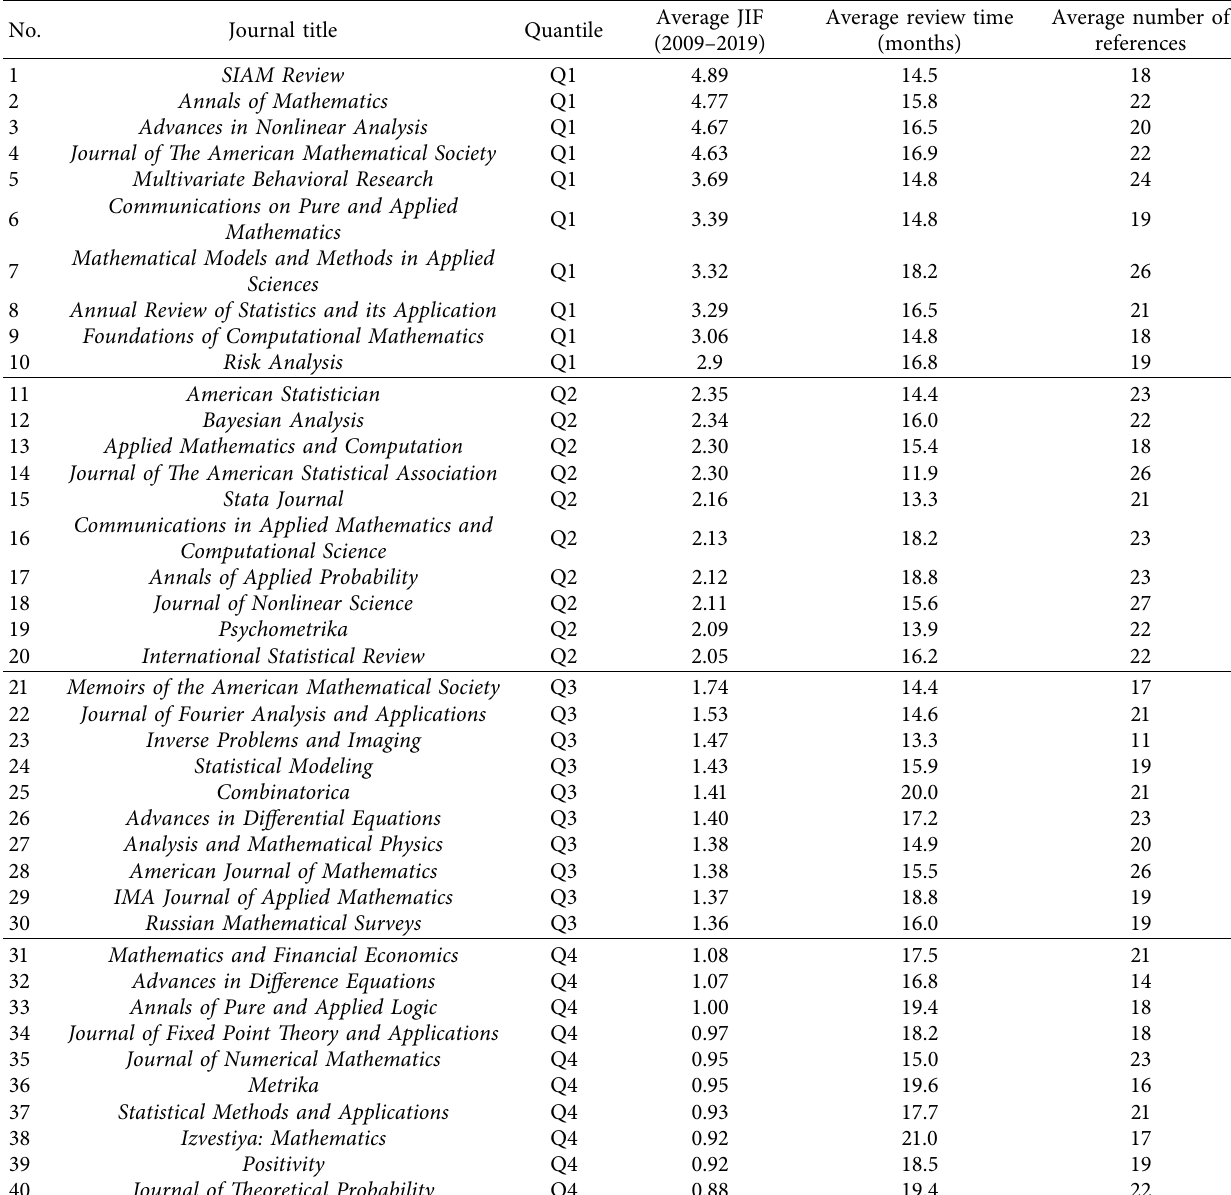
Table 5: Average JIF, average review time, and average number of references for 40 mathematics journals.